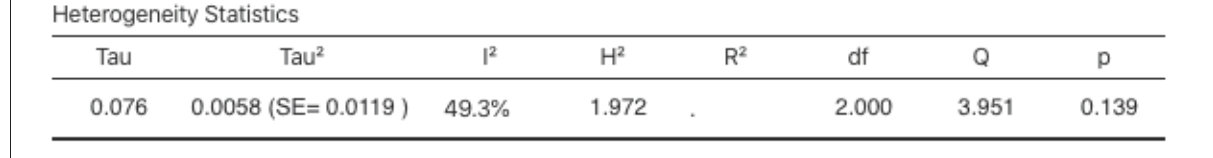
Figure 4. Heterogeneity assessment.